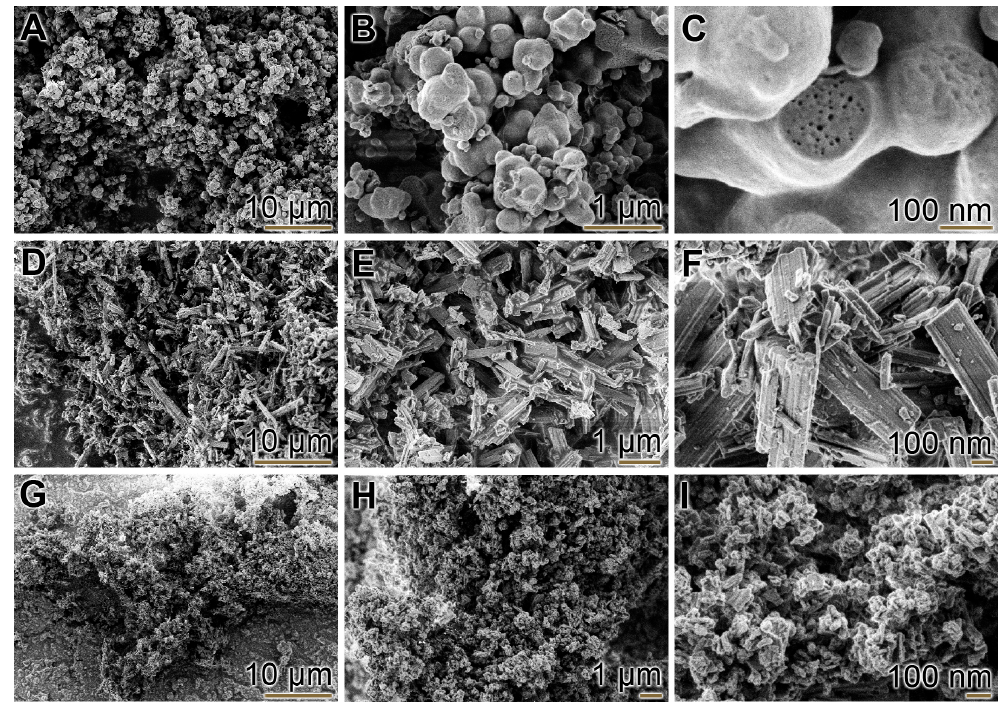
Figure 1. Morphology of the polyP and ZOL particles; SEM. Images from ( A – C ) amorphous “Ca-polyP-MP”, ( D – F ) crystalline “Ca-ZOL-MP”, and ( G – I ) amorphous hybrid “Ca-polyP-ZOL-MP”. ZOL, zoledronic acid.